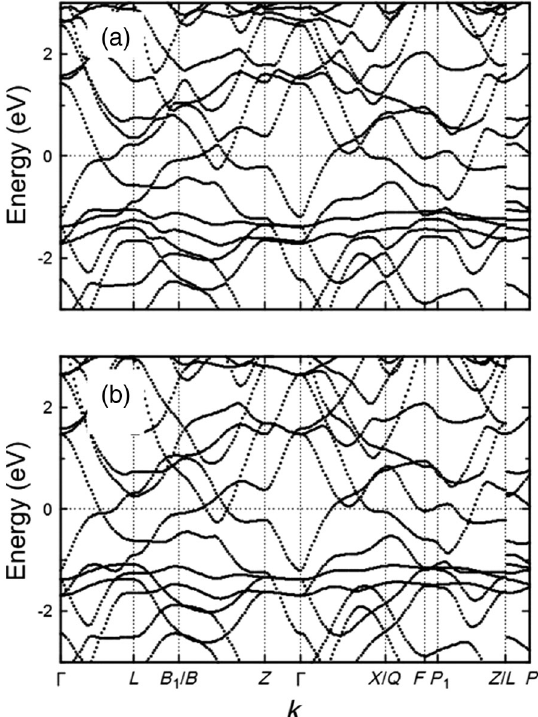
FIG. 15. Band structure of Gd 2 C calculated (a) with spin-orbit interaction and (b) without spin-orbit interaction. In (b), both spin channels are plotted